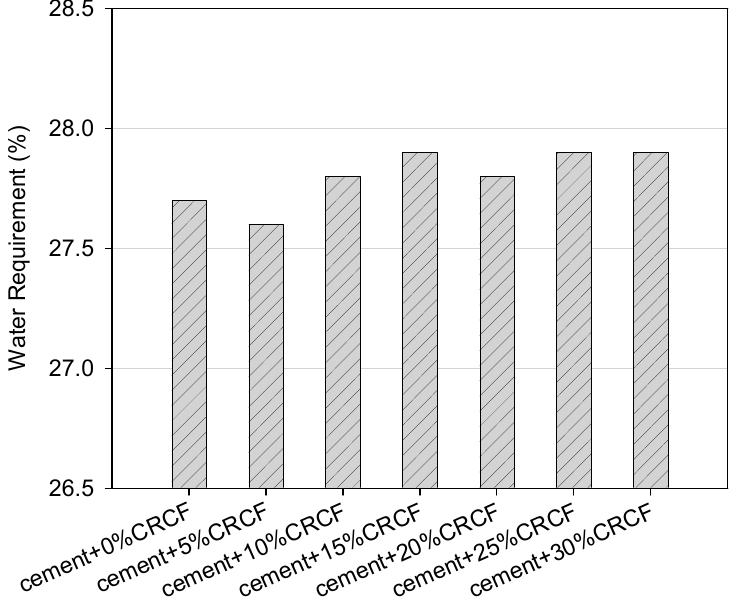
Figure 7. Water requirement of cement pastes with different CRCF contents.